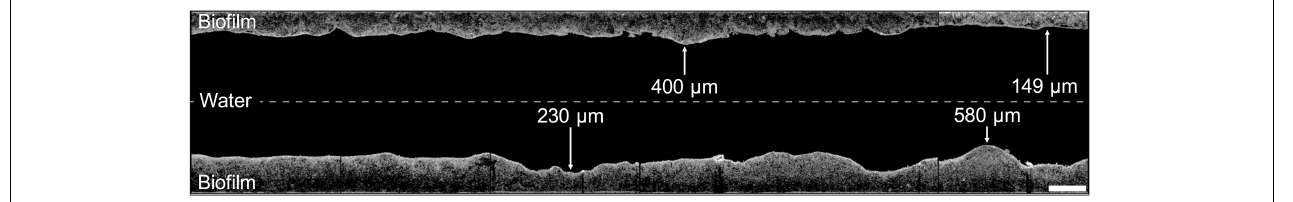
FIGURE 2 | Visualization of the control hose biofilm imaged with optical coherence tomography. Images (2 mm length) were combined to illustrate the biofilm structure and thickness of 1.2 cm-sections, showing a representative example of the shower hose biofilm. The hose was static and horizontally aligned, thus top and bottom in this image represent the actual orientation of the biofilm. The space between the top and bottom sections is not to scale. Scale bar: 500 µ